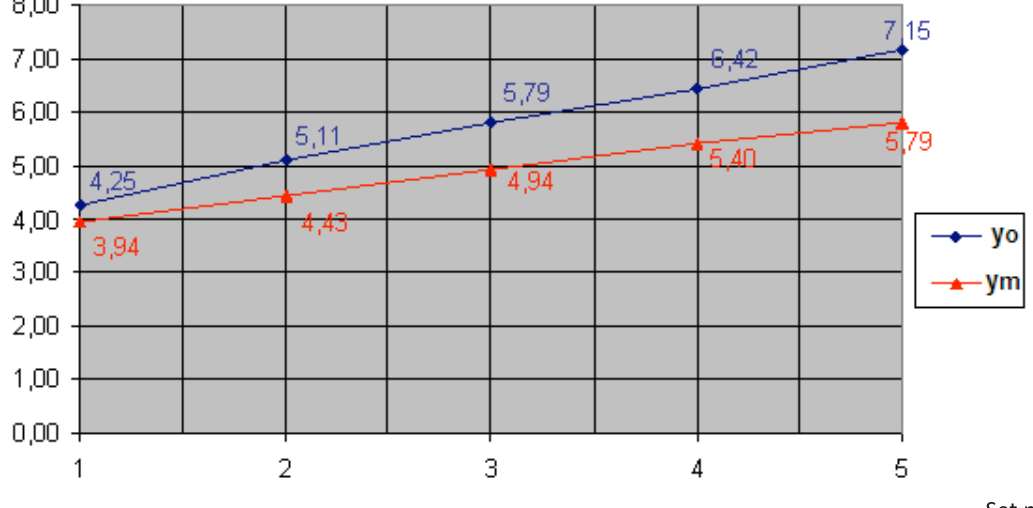
Fig. 2. Comparative analysis of control group data of October and May ping pong sets, where y and у – data for May; 1 – 5 numbers of sets; 0 – 8.00 – quantity of made m